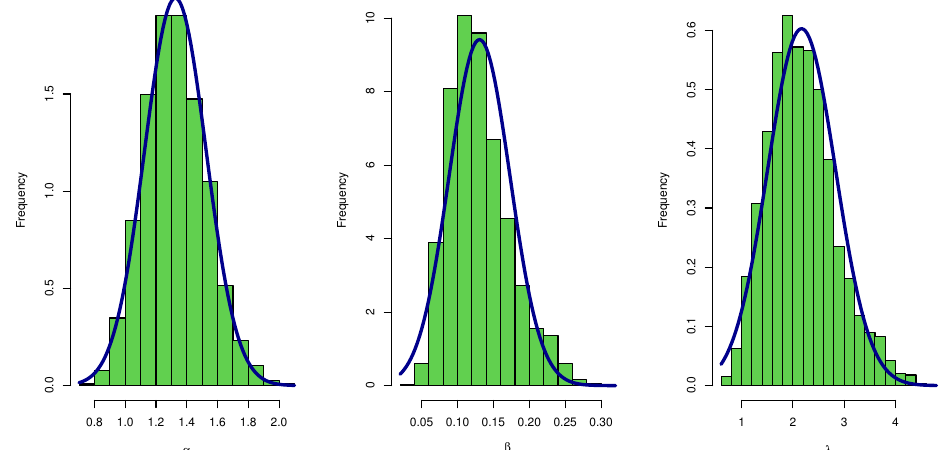
Figure 7. Density plot of posterior MCMC results for parameters of UEP for the recovery rate of COVID-19 data from